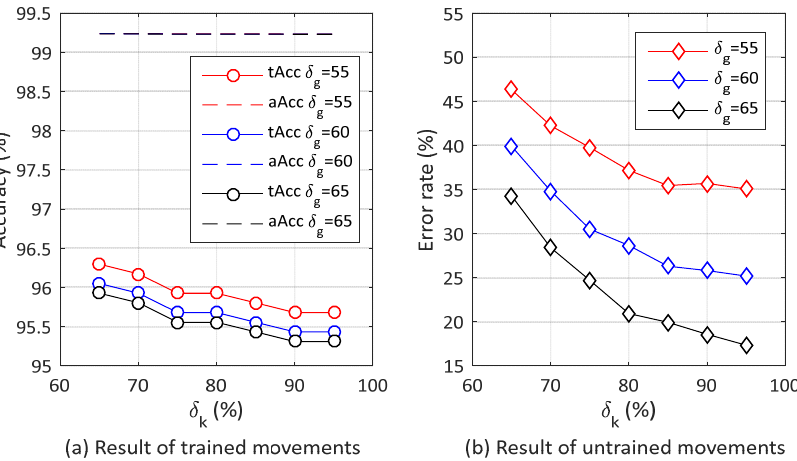
Figure 9. Average classification results of the six hand movements from Exercise B, Ninapro data ‐ base 1 for different values of δ g and δ k of GK ‐ R classifier. ( a ) Accuracy versus δ k for different values 1 for different values of δ g and δ k of GK-R classifier. ( a ) Accuracy versus δ k for different values of δ g . of δ g . ( b ) Error rate versus δ k for different values of δ g . ( b ) Error rate versus δ k for different values of δ g